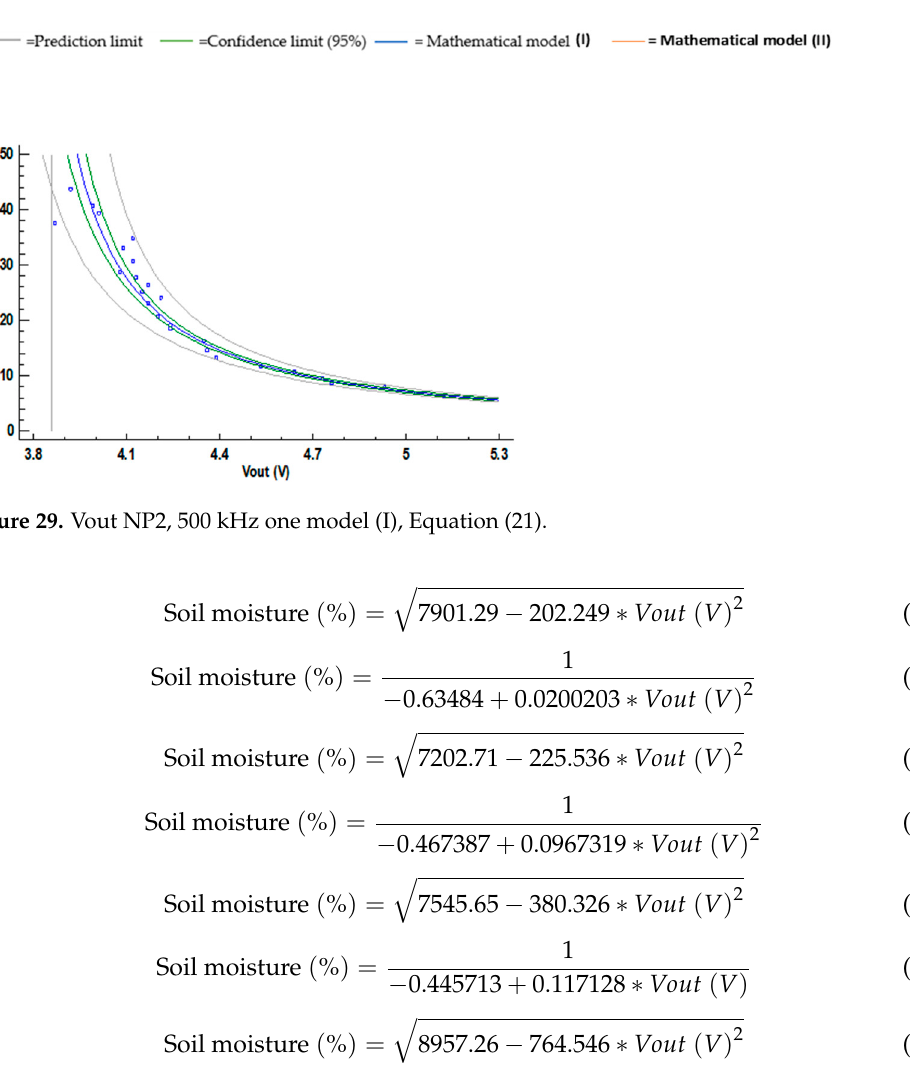
Table 9. Values of R2 and REs in NP2 (I) without the first values before the trend reversal occurs.